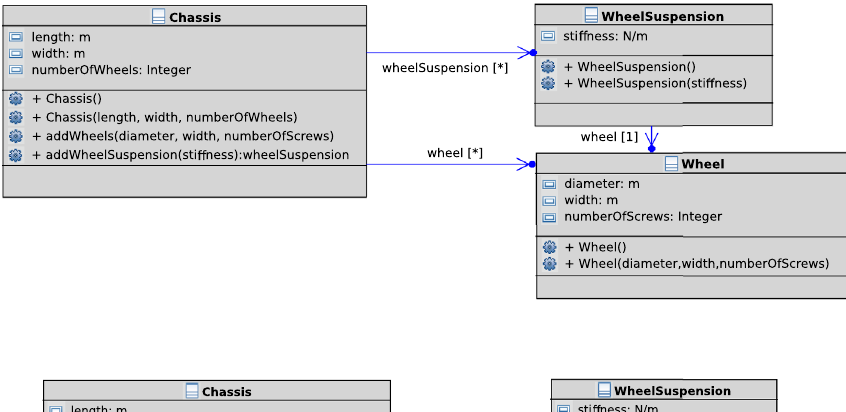
Fig. 7 The classes that realize an interface have to imple- ment the methods defined in the interface